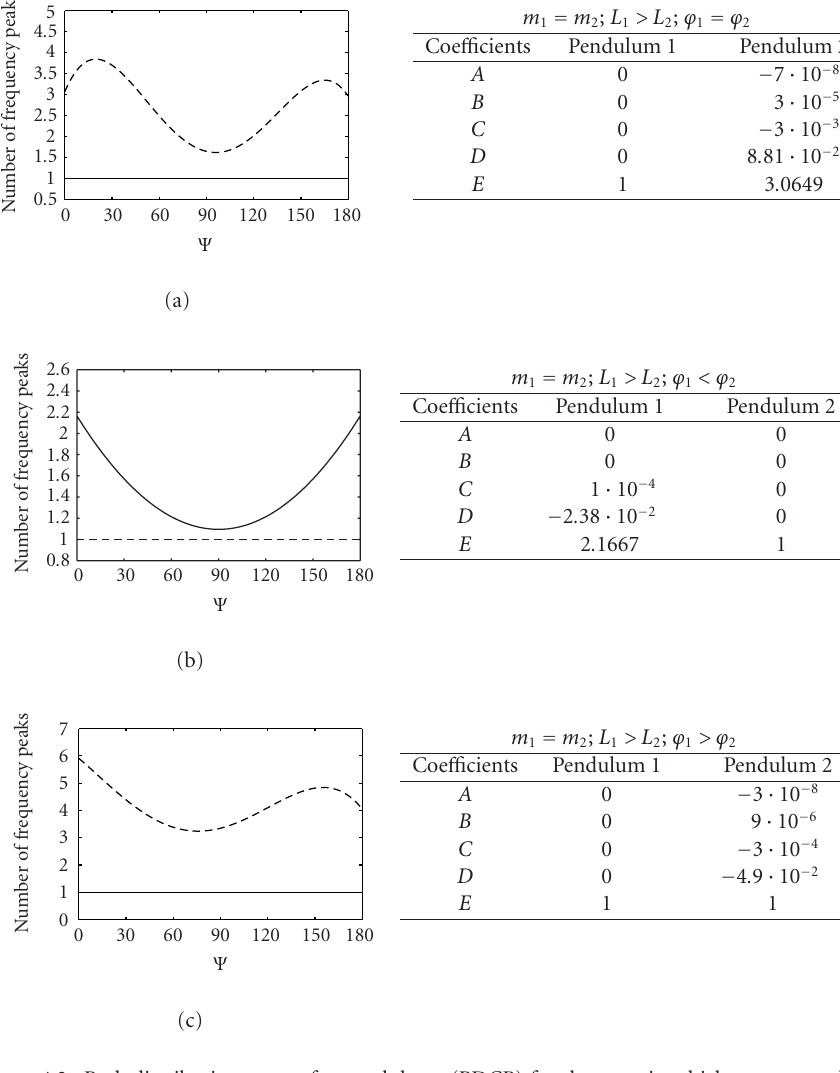
Figure 4.2. Peak distribution curves for pendulums (PDCP) for the cases in which m 1 = m 2 , where 0 . 5kg < m 1 < 4kg and 5 L 2 < L 1 < 15 L 2 where 0 . 1m < L 2 < 5m for: (a) ϕ 1 = ϕ 2 where 5 ◦ < ϕ 1 < 40 ◦ ; (b) 2 ϕ 1 < ϕ 2 < 6 ϕ 1 where 2 ◦ < ϕ 1 < 15 ◦ ; and (c) 2 ϕ 2 < ϕ 1 < 6 ϕ 2 where 2 ◦ < ϕ 2 < 15 ◦ . Solid curve is PDCP of pendulum 1, and doted curve is PDCP of pendulum